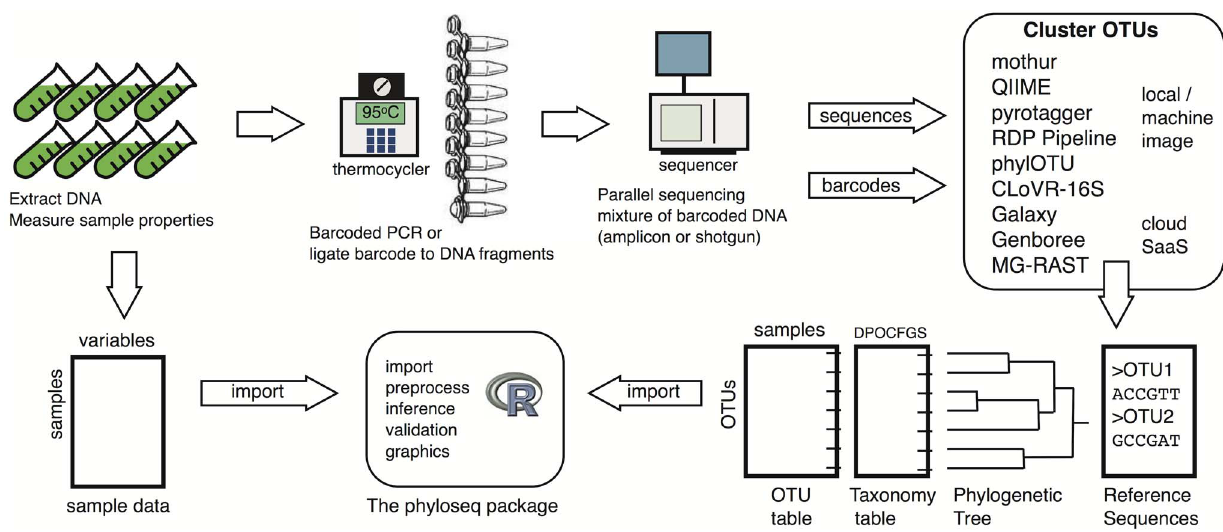
Figure 1. Example of a phylogenetic sequencing workflow. A diagram of an experimental and analysis workflow for amplicon or shotgun phylogenetic sequencing. The intended role for phyloseq is indicated.